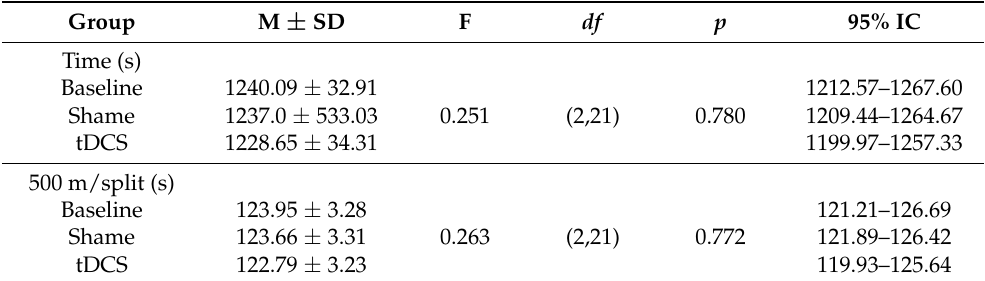
Figure 2. Overview of endurance performance and individual variation in time, 500 m/split and power during 5 km row. ( a ) is the endurance performance at baseline, transcranial direct current stimulation (DCS) and sham conditions. No significant differences were found between the three conditions as regards time, 500 m/split or power. ( b ) is the variation in individual endurance performance between tDCS and sham; seven of the rowers improved following tDCS, and five improved following sham. Data are presented as mean ± SD; n = 8. Table 1. Overview of endurance performance of elite professional female rowers at baseline, tDCS and sham during 5 km row (data are presented as mean ± SD; n = 8).